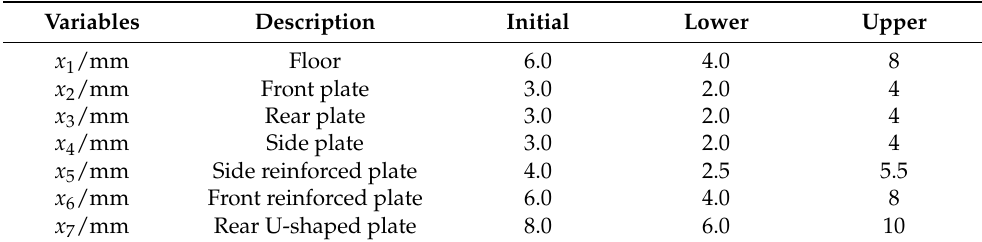
Table 3. Value range of design variables.